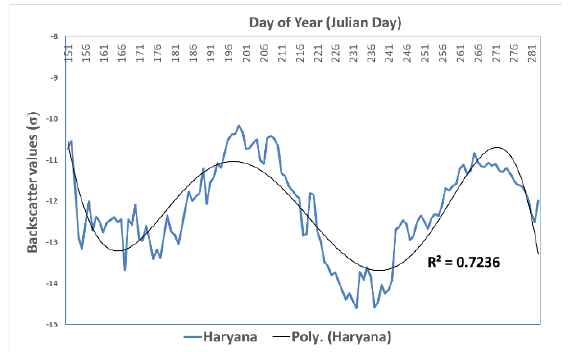
Figure 15: Polynomial Curve fitted over rice